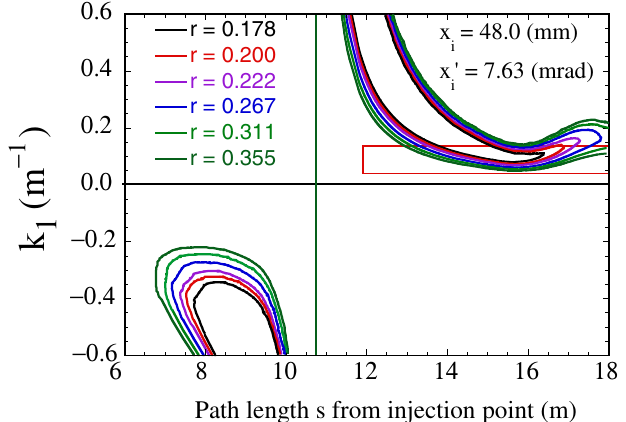
FIG. 9. (Color) Physical strength k length s from the injection point and reduction ratio r